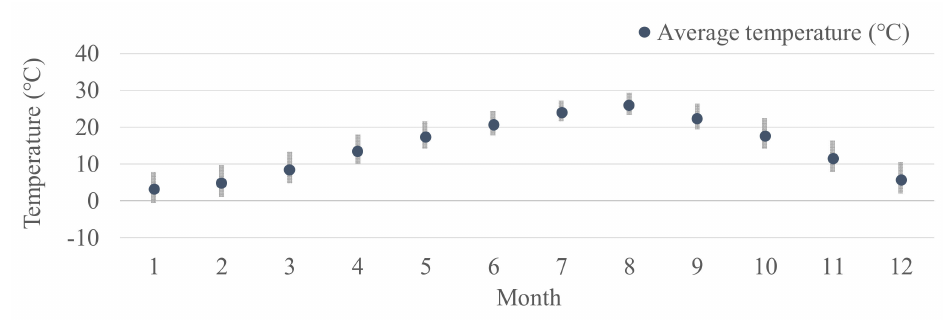
Figure 4. Monthly air temperature data from 1981 to 2010.